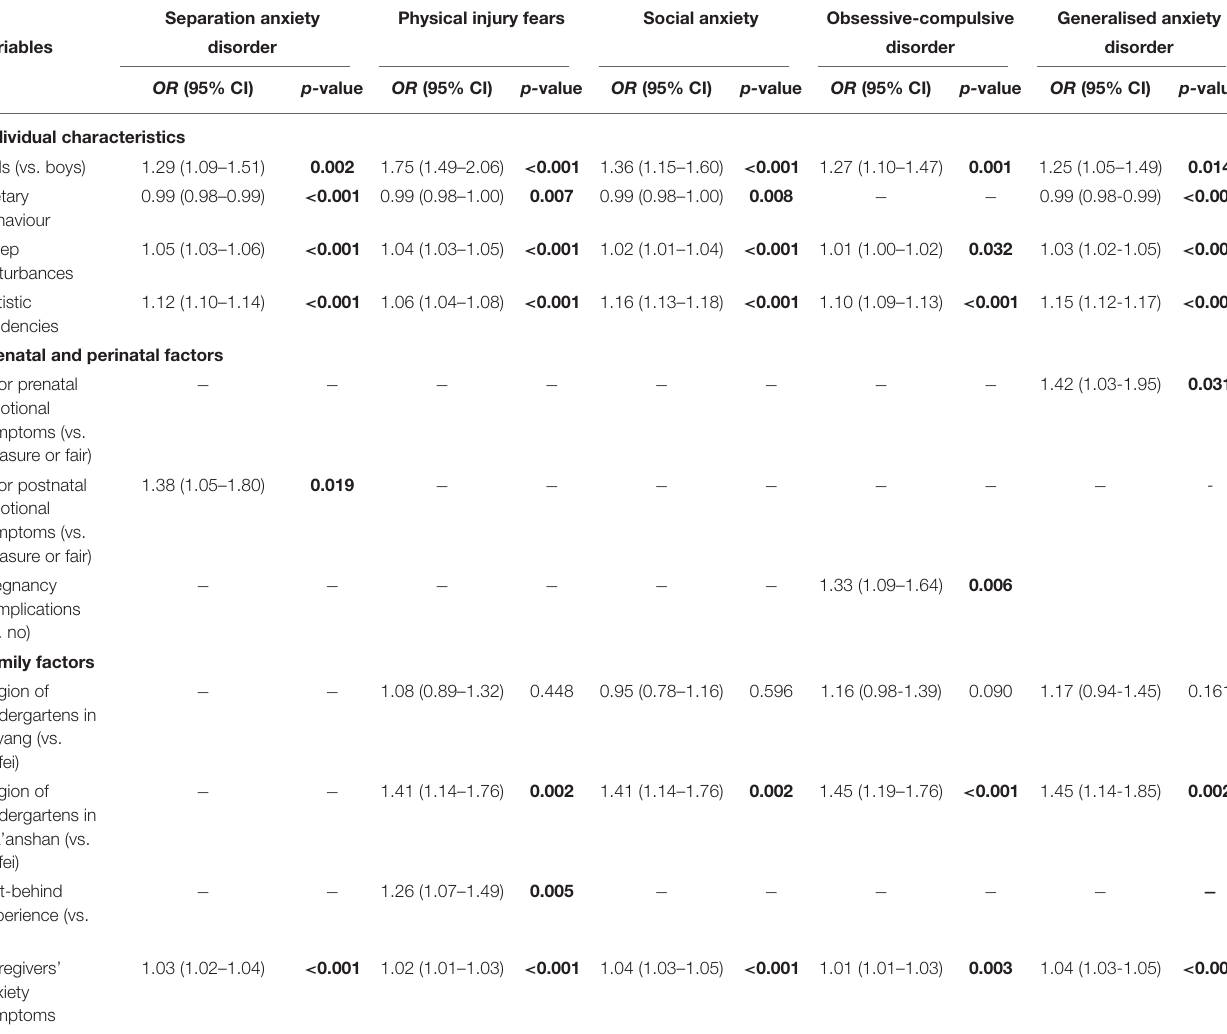
TABLE 4 | Multivariate logistic regression models anxiety symptoms in different subtypes and associated factors among preschool children. Separation anxiety Physical injury fears Social anxiety Obsessive-compulsive Generalised